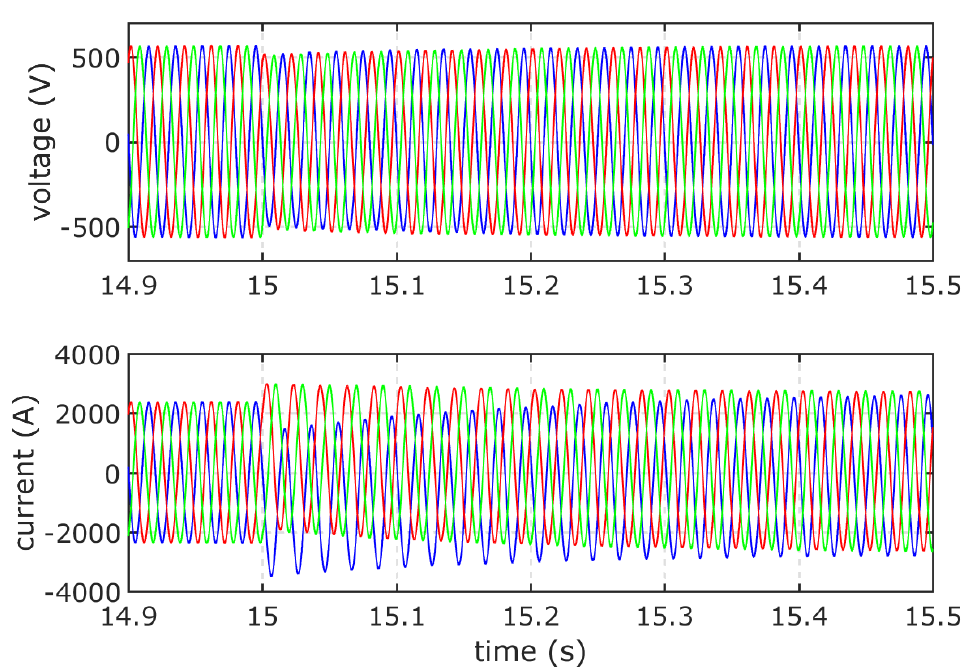
Figure 11. Operation at variable load and constant wind speed: instantaneous load voltage and current under reactive power step (phase a-red; phase b-green; phase c-blue).